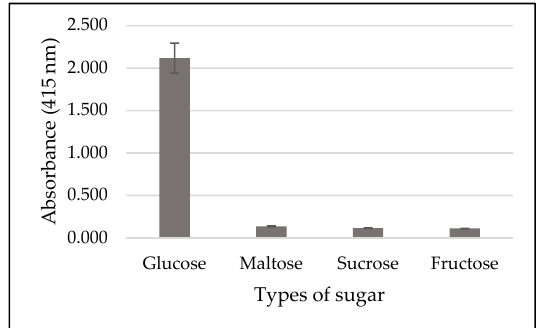
Figure 6. Specificity test of immobilized GOx using glucose (1.25 mM), maltose (1.25 mM), sucrose (1.25 mM), and fructose (1.25 mM).